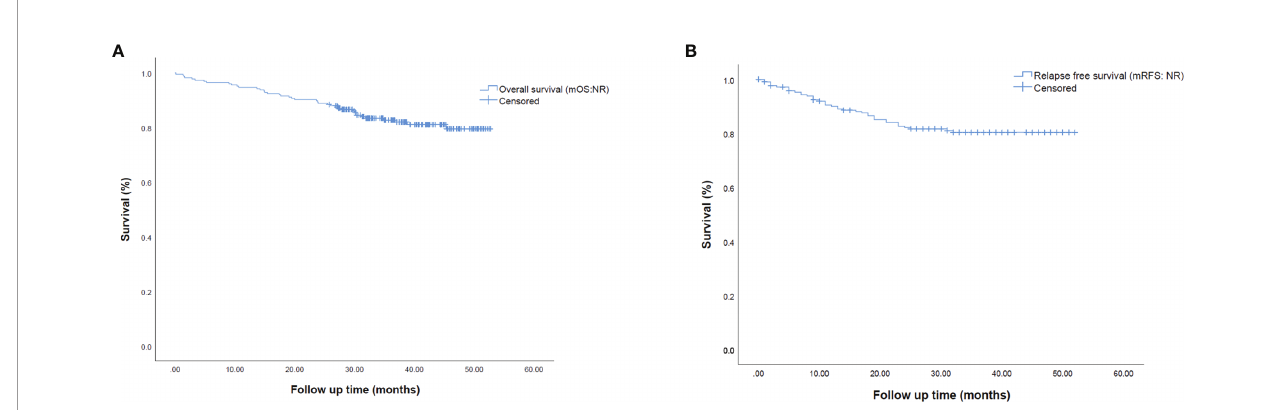
FIGURE 2 | Kaplan-Meier survival curves representing (A) median overall survival (mOS) and (B) median relapse-free survival (mRFS) in the overall population of early-stage resected NSCLC patients.